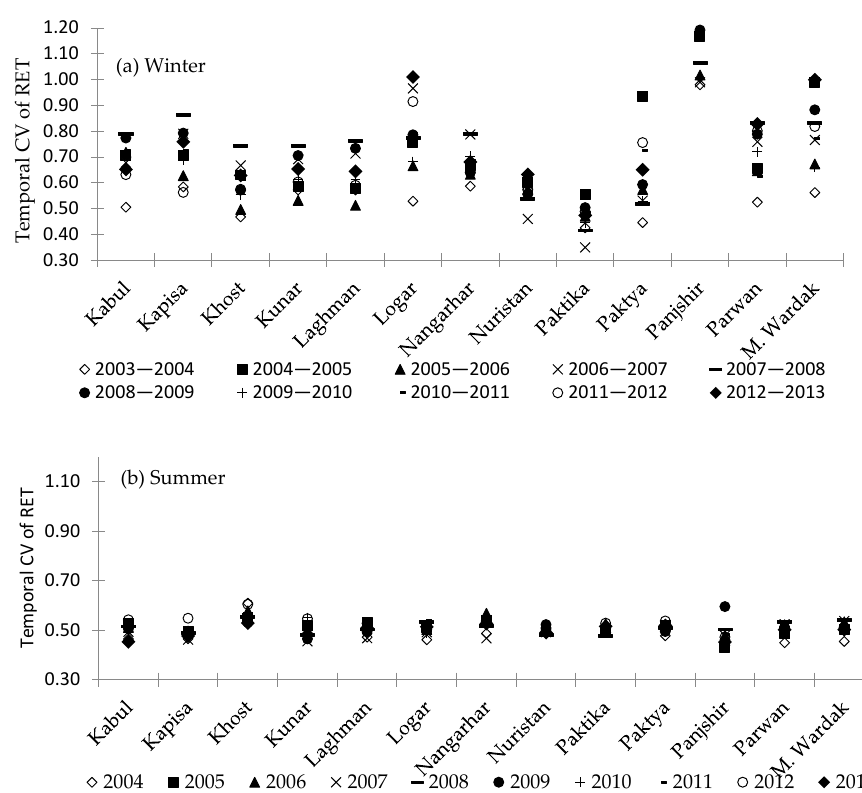
Figure 12. Temporal coefficient of variation (2003–2013) of relative evapotranspiration during ( a ) winter and ( b ) summer.